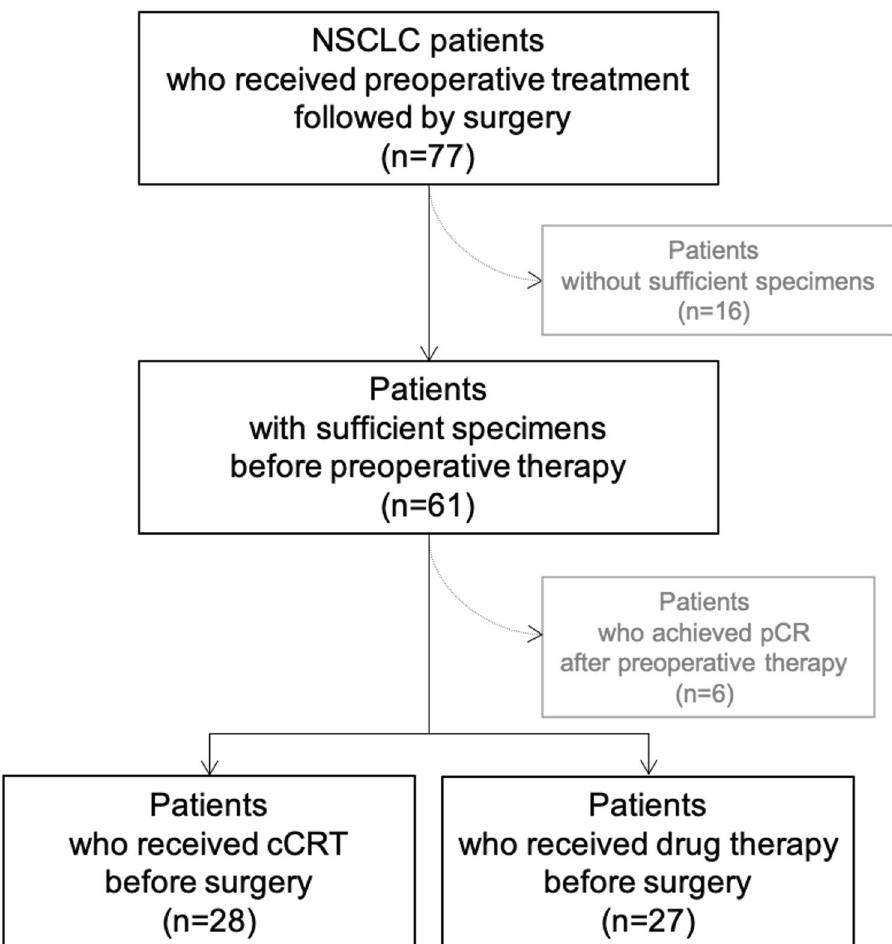
Figure 1. Flow diagram of the present study